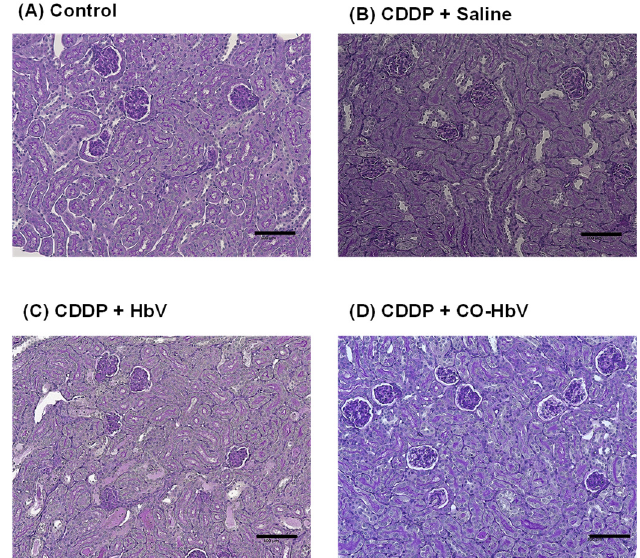
Figure 2. Representative imaging of kidney stained by PAS at 96 h after each sample treatment in cisplatin (CDDP) mouse model. ( A ) Control mice (without CDDP treatment), CDDP mouse model treated with ( B ) saline, ( C ) Hemoglobin-vesicle (HbV), and ( D ) carbon monoxide (CO)-loaded HbV (CO-HbV). Scale bar: 100 µm.